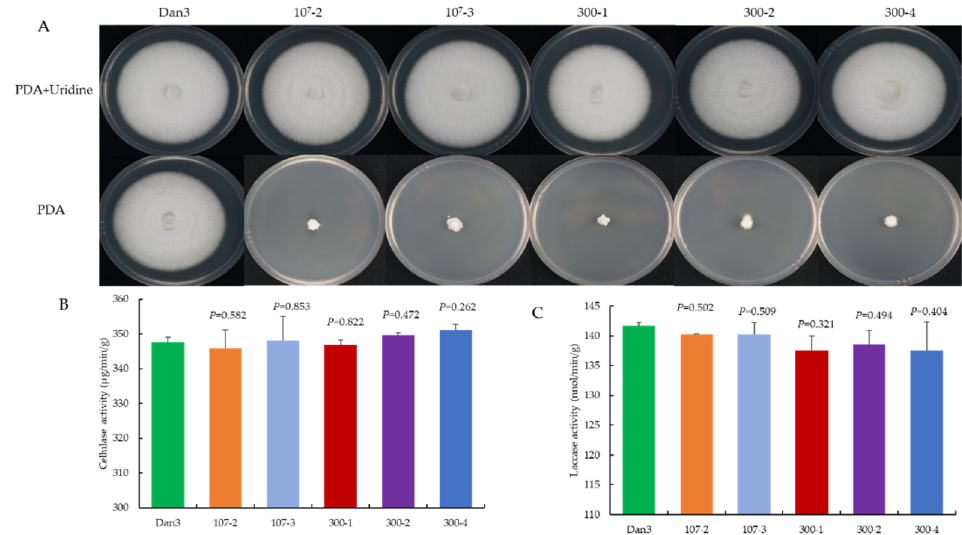
Figure 6. Comparative analysis of RNP-directed mutants and their parental strains. ( A ) Phenotype of Dan3 and its pyrG mutants on PDA plates (with/without uridine). Dan3: wild-type. 10 7 -2, 10 7 -3, 300-1, 300-2, 300-4: pyrG mutants edited with RNP. ( B ) Cellulase activities of Dan3 and corresponding pyrG mutants. ( C ) Laccase activities of Dan3 and corresponding pyrG mutants. Error bars indicate the standard deviation of three replicates. All p -values were obtained using two-tailed t-tests in Microsoft Excel.